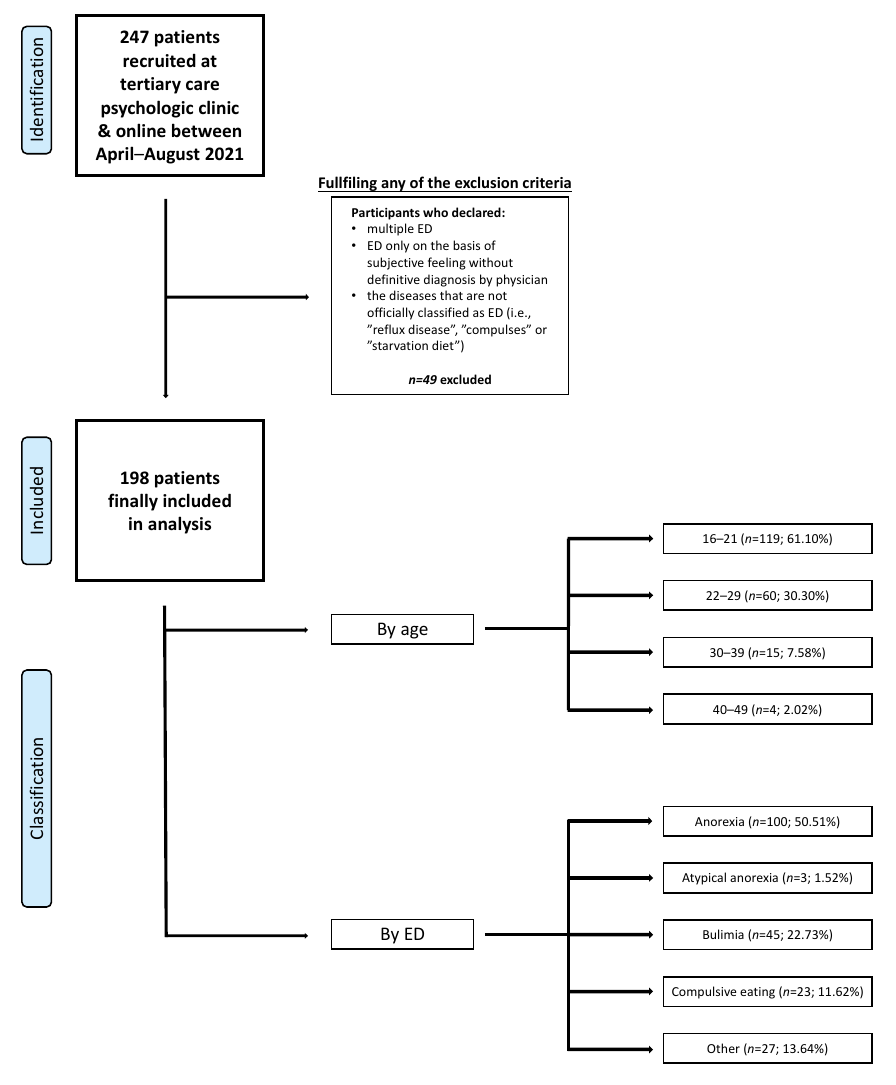
Figure 1. Flowchart of the participants selection process. Study population consisted of patients who declared themselves as females ( n = 195; 98.48%) or did not want to specify gender ( n = 3; 1.52%). There was no males willing to participate in the study. Data are presented as the number of patients and as a percentage of the whole group. Age classification has been shown in years. Abbreviations: ED, eating disorder.